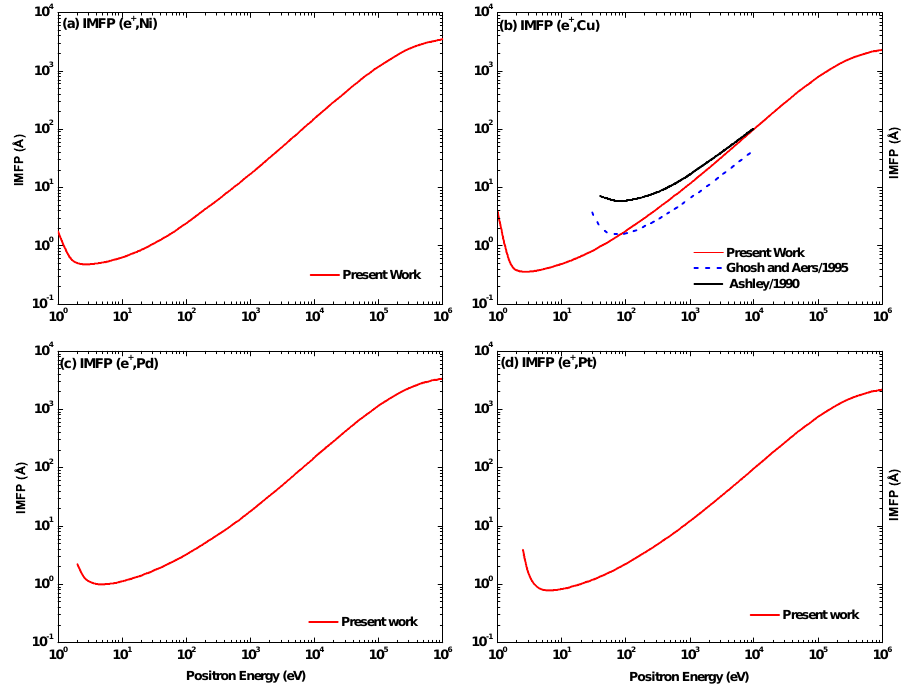
Figure 41. Inelastic mean free path λ in (IMFP) in ˙A for positrons colliding with ( a ) Ni, ( b ) Cu, ( c ) Pd, and ( d ) Pt as function of collision energy, E i . Shown are the present results (——-, red) and the theoretical results from Ashley (——-, upper line in ( b ), black [74]) and Ghosh and Aers ( − − −− , blue